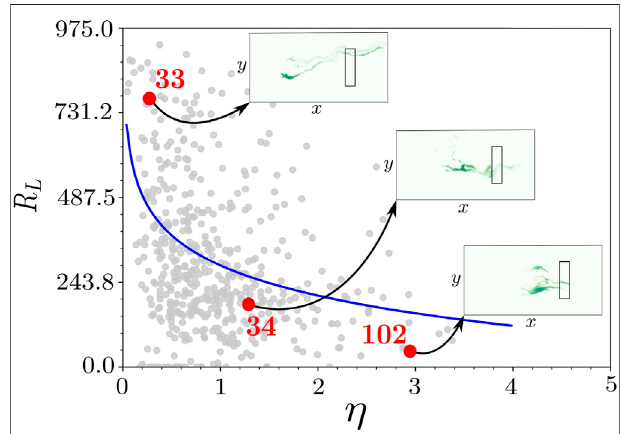
FIGURE 7 | Maximum value of resilience loss ( R L [d]) experienced within the target area versus contaminant source ef fi ciency ( η [-]) for all the Monte Carlo realizations. Data (gray dots) are fi tted by a logarithmic curve, the blue line in the plot. The red dots highlight three Monte Carlo realizations, the 33 rd , 34 th and 102 nd , in which the spatial con fi guration of the contaminant plumeisinvestigated at agiven timesnapshot.Theinsets areconnected, bya black arrow, to the simulated scenario. The black rectangles in the insets represent the environmentally sensitive target location.